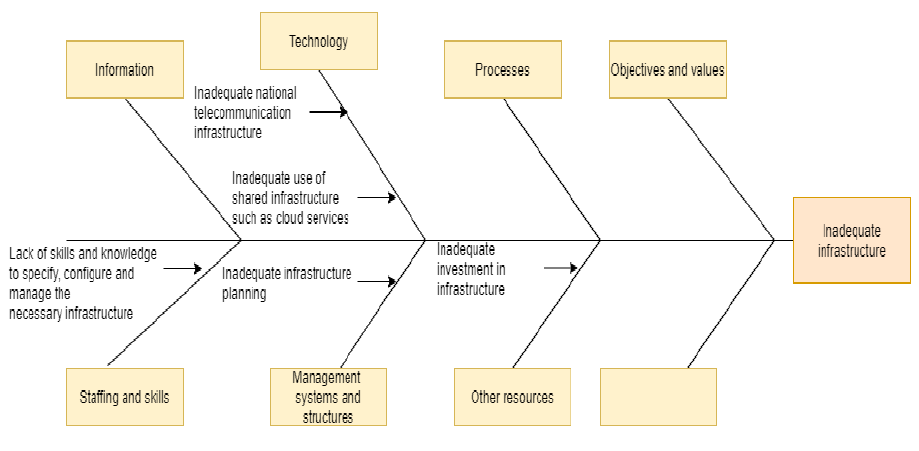
Figure 17: Inadequate